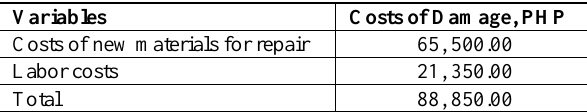
Table 5 . Total value of damage to farmhouse